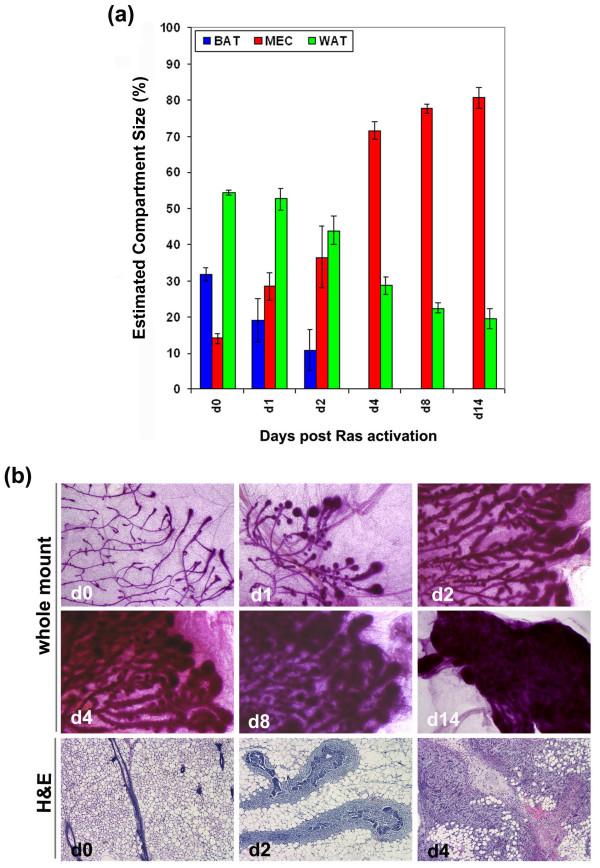
Changes in cell compartment sizes following Ras activation in the mammary gland. (a) Calculated proportions of BAT, WAT, and MEC compartments in the mammary gland at the indicated days following oncogenic Ras activation in MTB/TRAS mice (mean ± SEM). Ras activation expands the epithelial compartment and decreases the adipocyte compartment. (b) Carmine-stained whole mounts (magnification 10×) and H&E-stained sections (magnification 100×) of number 3 mammary glands in MTB/TRAS mice showing changes in the sizes of cell compartments following oncogenic Ras activation similar to those predicted by deconvolution analysis.